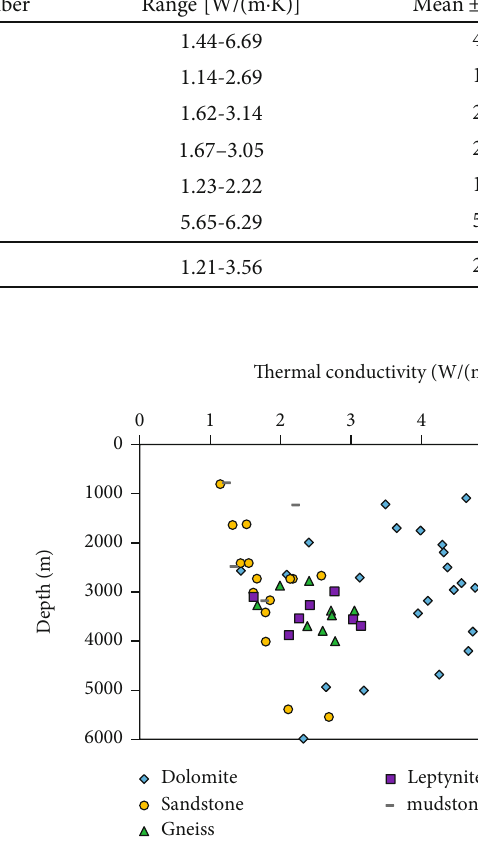
Figure 7: Relation between thermal conductivity of rocks and depth in Xiong ’ an New Area.